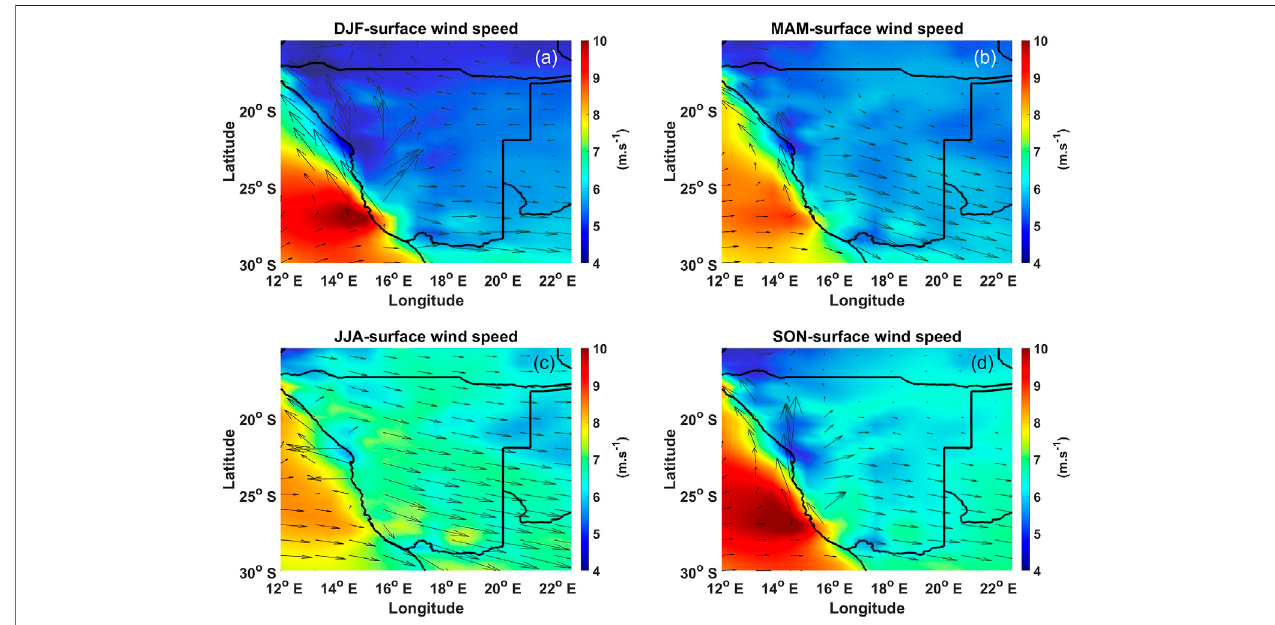
FIGURE 4 | Seasonal averaged wind speed overlay with wind vectors from 1998 to 2020 in (A) DJF, (B) MAM, (C) JJA and (D) SON, obtained from MERRA-2.